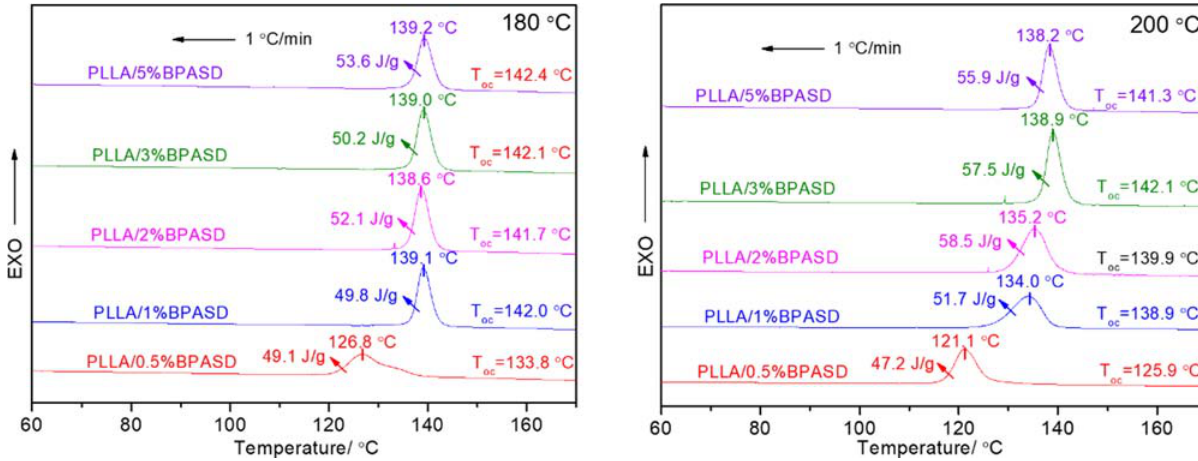
Figure 4: Melt - crystallization DSC curves of the PLLA/BPASD samples from the di ff erent melting